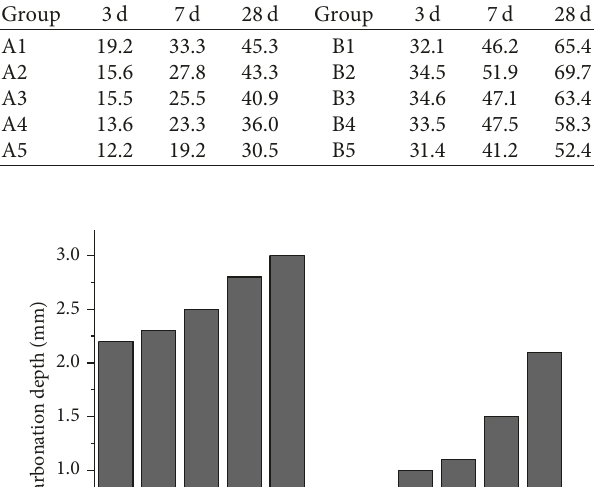
Figure 1: Slumps of concrete. Table 5: Compressive strength at different ages of concrete (MPa). Group